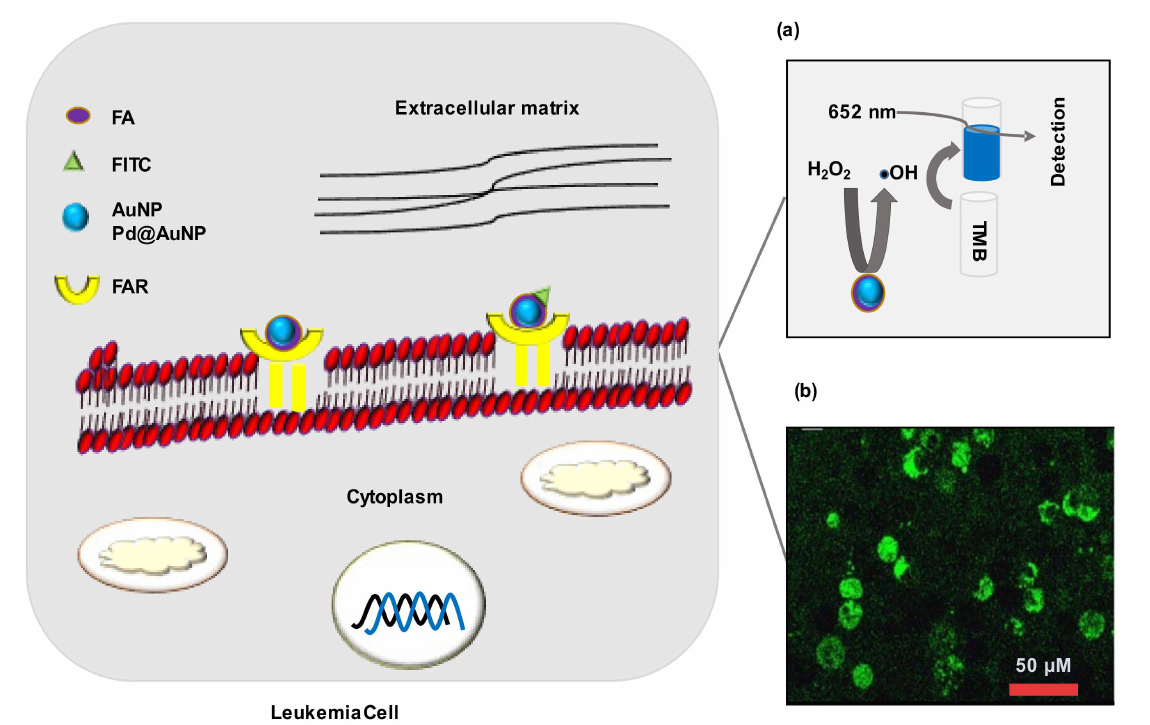
Figure 5. Gold-nanomaterials-based leukemia detection. FA conjugated GNMs interact with the FAR overexpressed leukemia cells. ( a ) Interaction between FAR with FA-Pd@AuNP can be confirmed by the colorimetric method. Enzymatic activity of FA-Pd@AuNP covert H 2 O 2 to • OH. • OH interacts with TMB to form a blue color that can be detected at the 652 nm wavelength. ( b ) FA-loaded AuNPs labeled with FITC binds with FAR overexpressed leukemia cells; the interaction could be confirmed by confocal microscopy, based on the green fluorescence of the FITC reporter. These images indicate potential results, but they do not reflect any actual experiments. Gold nanomaterials: GNMs; Folic acid: FA; Folic-acid receptor: FAR; Palladium gold nanoparticles: Pd@AuNPs; Gold